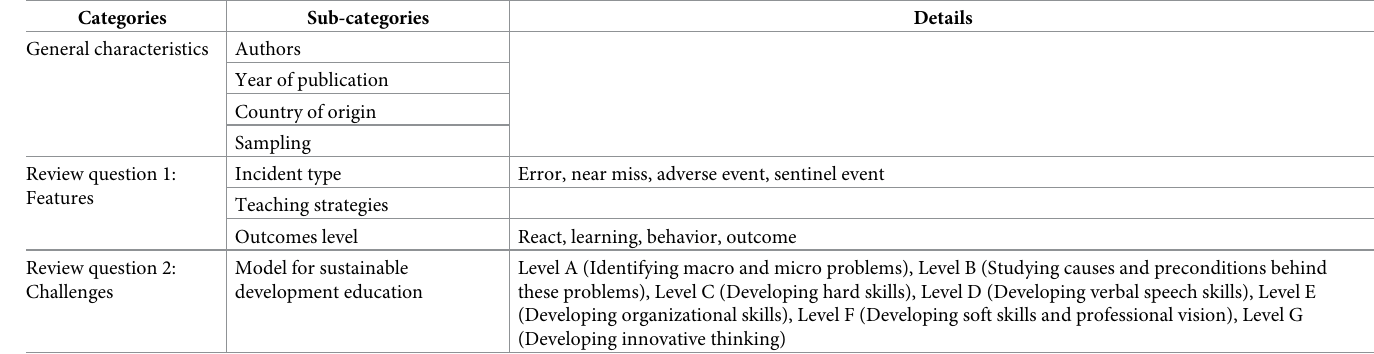
Table 2. Extraction